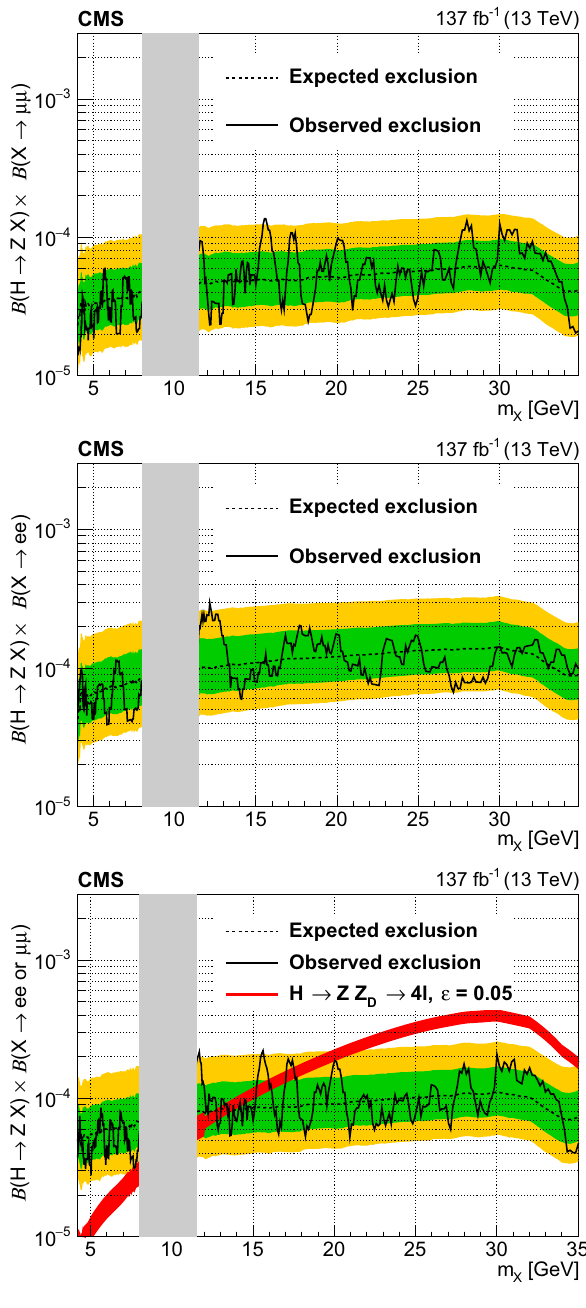
Fig. 4 Expected and observed 95% CL limits on B ( H → ZX ) B ( X → μμ ) assuming X decays to dimuons only, B ( H → ZX ) B ( X → ee ) assuming X decays to dielectrons only, and B ( H → ZX ) B ( X → ee or μμ ) assuming a flavor symmetric decay of X to dimuons and dielectrons. The dashed black curve is the expected upper limit, with one and two standard-deviation bands shown in green and yellow, respectively. The solid black curve is the observed upper limit. The red curve represents the theoretical cross section for the signal process H → ZX → 4 (cid:2) . The discontinuity at 12GeV in the uncertainty is due to the switch from experimental to theoretical uncertainty estimates of → eeor μμ ) ,asdescribedinRef.[7].Thesymbol ε isthekinetic- B ( Z D mixing parameter. The grey band corresponds to the excluded region around the bb bound states of